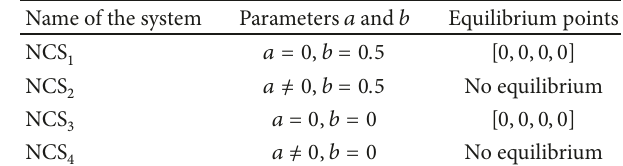
Table 1: Different cases for the parameters 𝑎 and 𝑏 . Name of the system Parameters 𝑎 and 𝑏